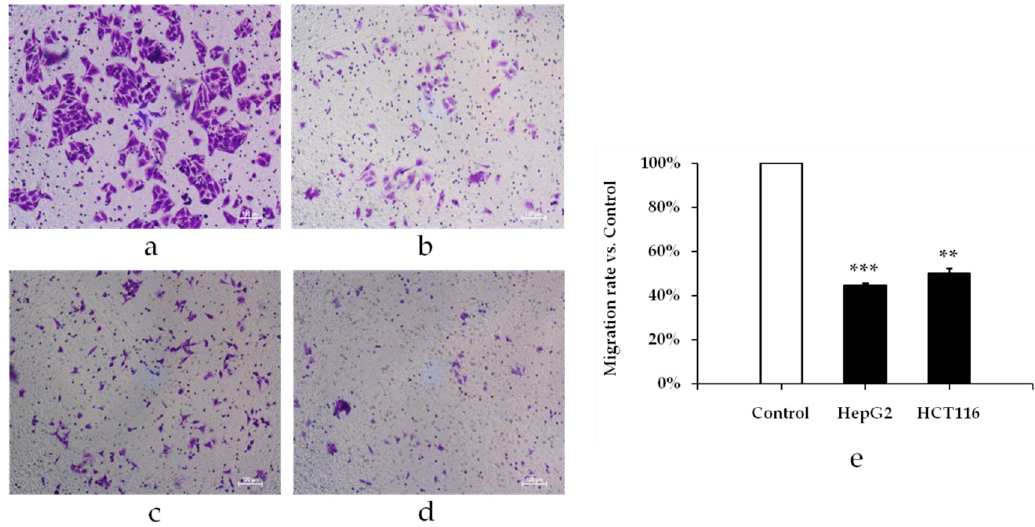
Figure 4. The effect of GOEO on migration of cancer cells. ( a ) HepG2 cells; ( b ) HepG2 cells treated with 0.3 µ L/mL of GOEO; ( c ) HCT116 cells; ( d ) HCT116 cells treated with 0.3 µ L/mL of GOEO; ( e ) Percentage of migration cells compared with the control group. The cell mobility of the control was set to 100%.